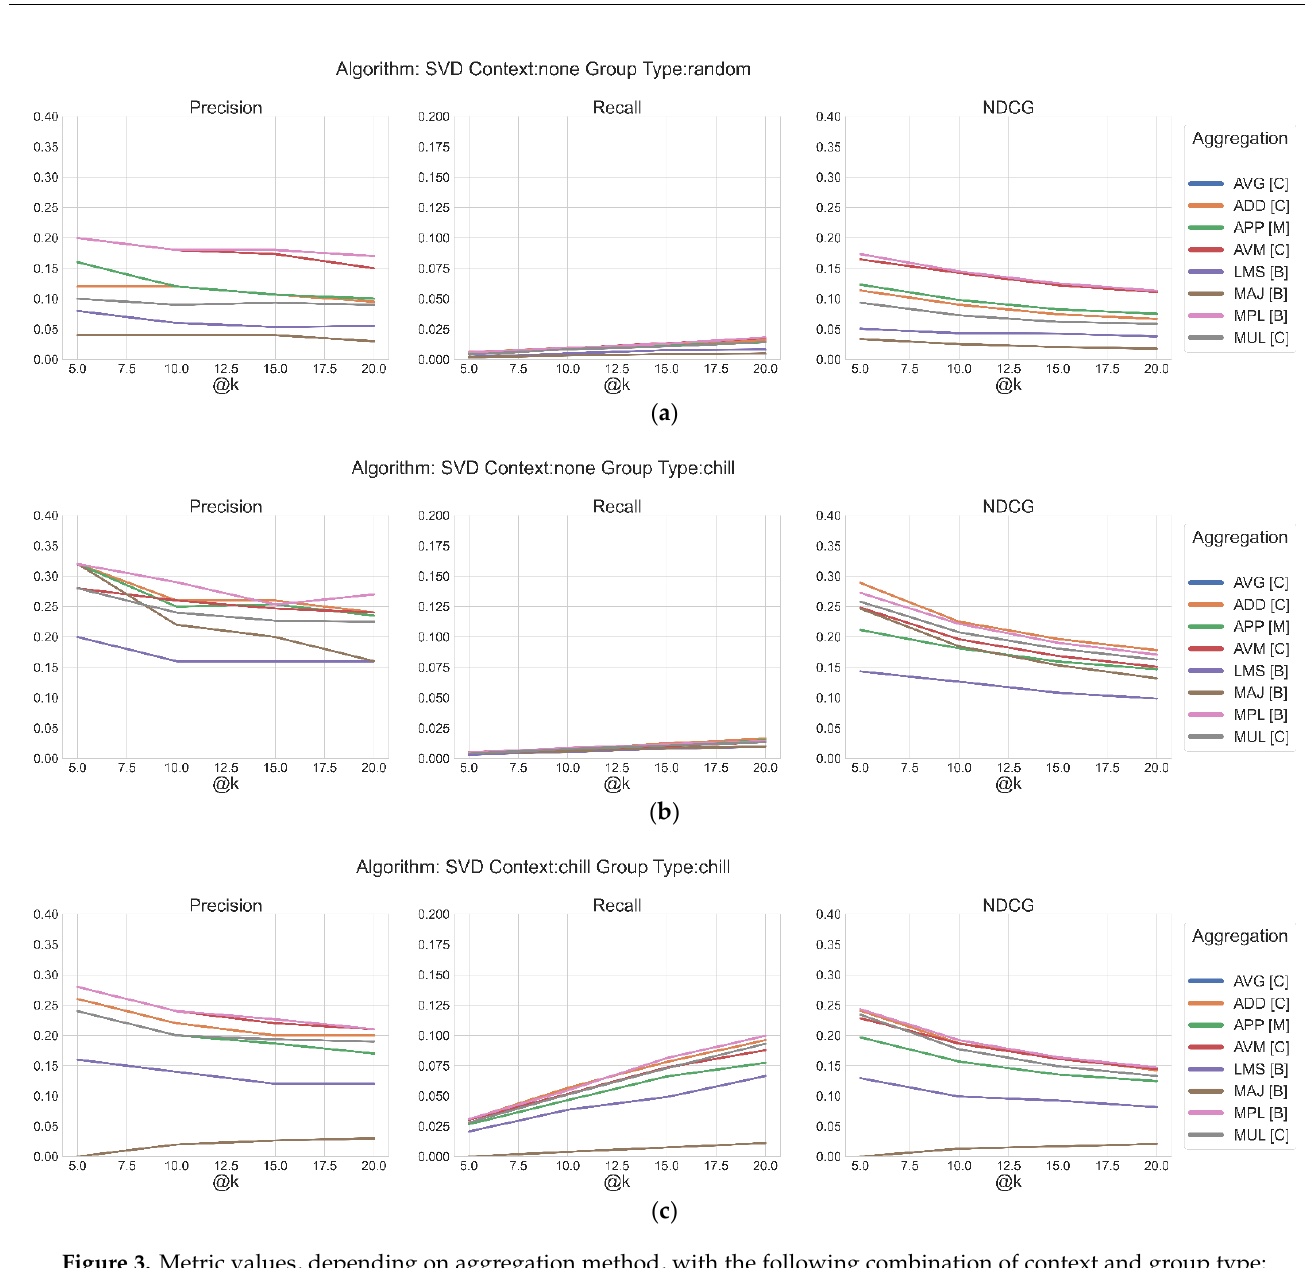
Figure 3. Metric values, depending on aggregation method, with the following combination of context and group type: ( a ) none–random, ( b ) none–chill, and ( c ) chill–chill for LastFM-lk-spotify dataset.